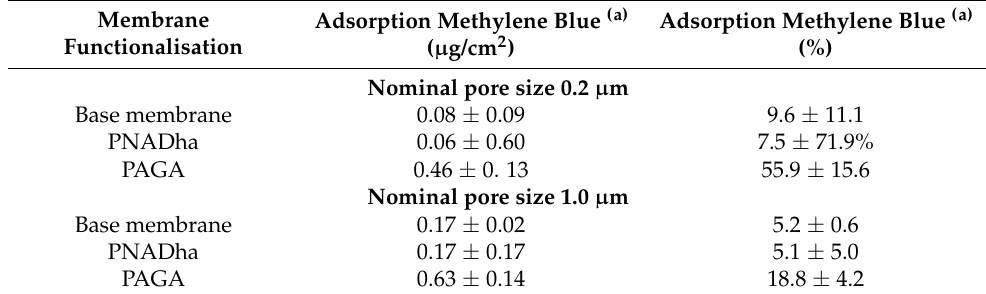
Table 2. Adsorption of methylene blue from a solution with the initial concentration of 0.1 mg · mL − 1 onto track etched membranes with various surface